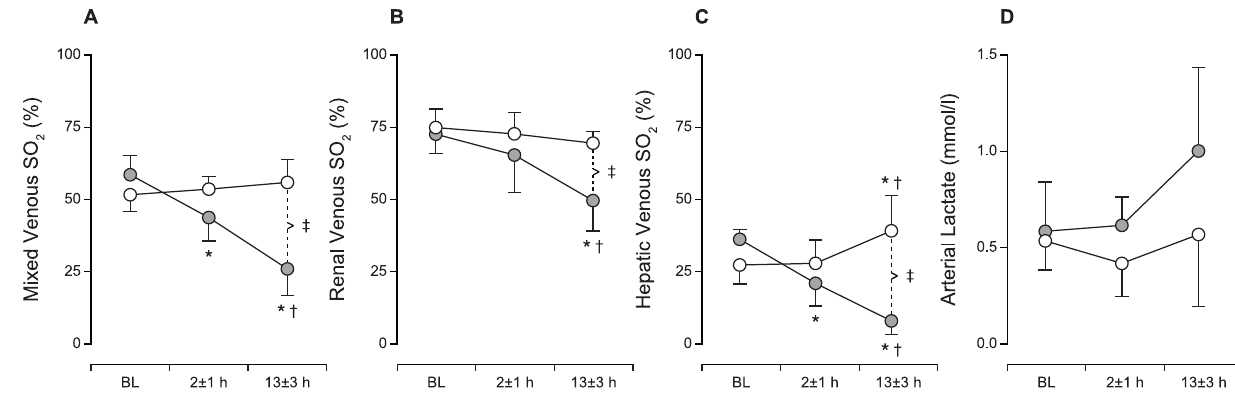
Figure 2. Metabolism. A–C: Mixed venous, renal venous and hepatic venous O 2 saturations (SO 2 ) were reduced following coronary microembolization. D: No increase in arterial lactate was observed despite profound shock. The data are presented as mean 6 SD. Open circles, time- matched control group; filled circles, cardiogenic shock group. * p , 0.05 within group compared to baseline, { p , 0.05 within group compared to 2 6 1 hours, ` p , 0.05 between groups.